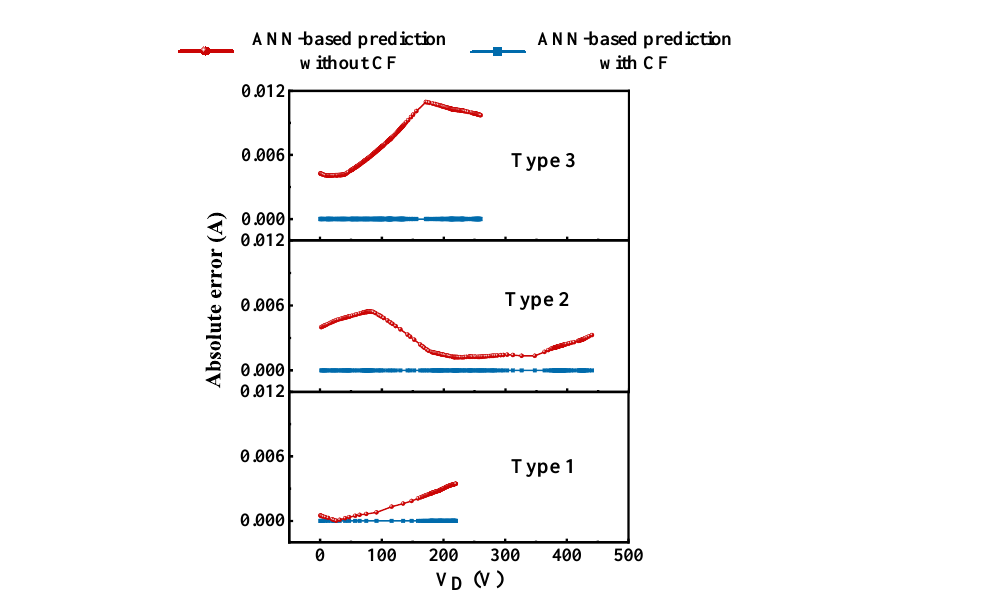
Figure 6. The predicted results with and without the conversion function (CF).